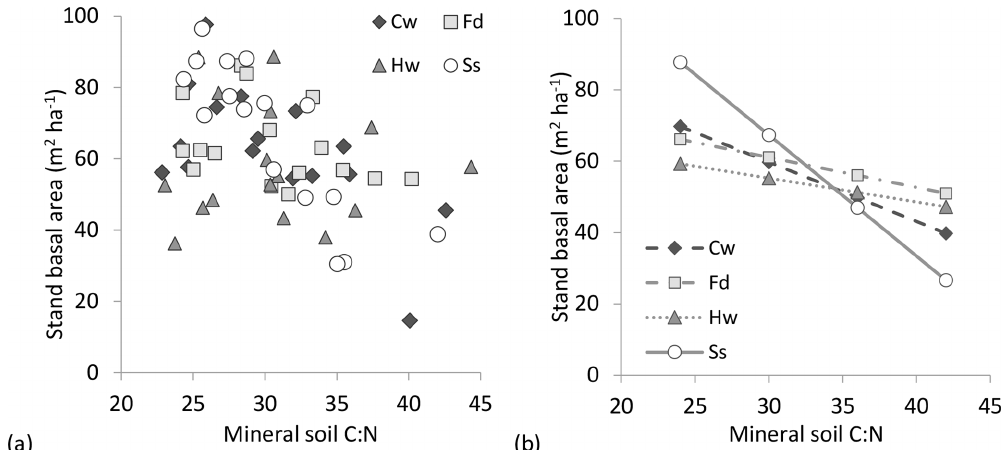
Figure 4. (a) Basal area by species in relation to mineral soil C:N molar ratio (all planting densities included) and (b) linear regressions between stand basal area and mineral soil C:N, fitted by spacing, species and species × soil interactions (output averaged across planting density; species × soil C:N p = 0 . 009, R 2 = 0 . 56). Slope of the C:N regression was steepest for Picea sitchensis (Ss; − 3.40), followed by